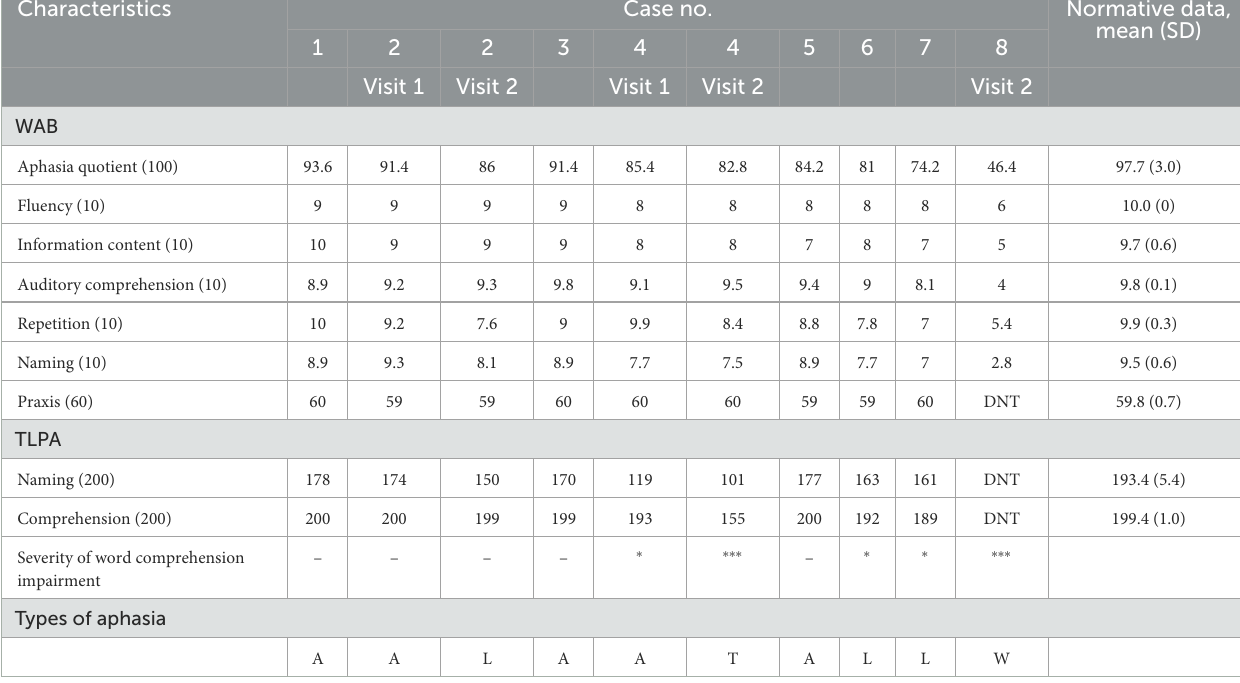
TABLE 2 Patients’ performance in language tests.